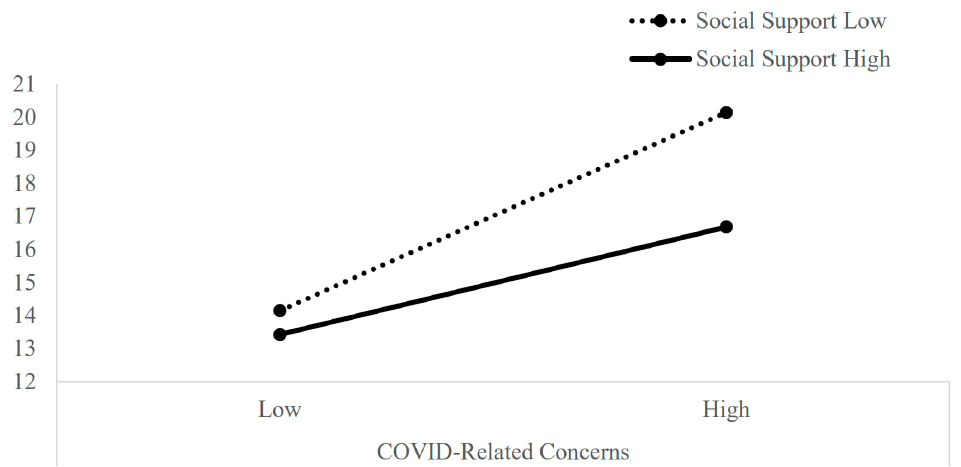
Figure 3. Results for the Direct, Mediation and Moderation Effects of Exposure to CST (Terror Threats), COVID-19-Related Stressors, and Perceived Social Support on Depressive